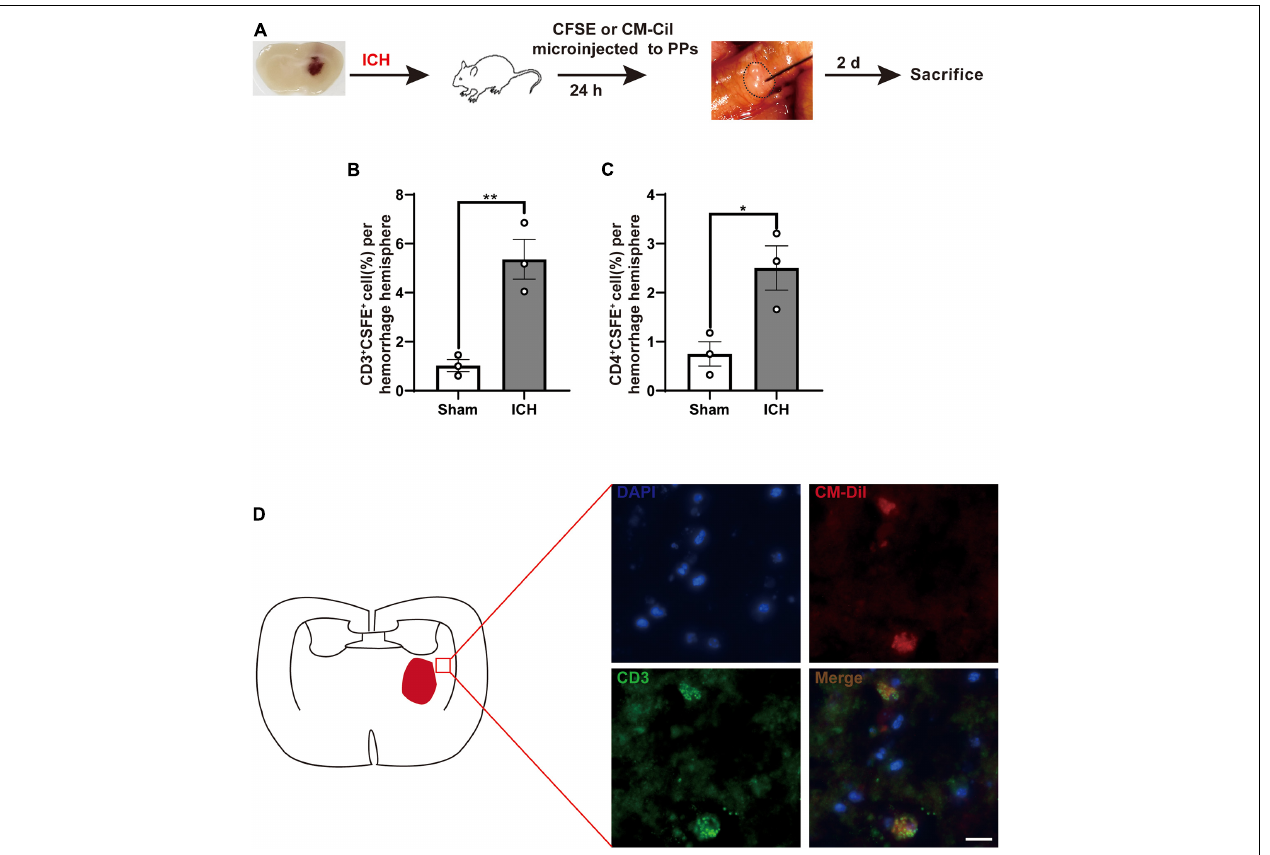
FIGURE 4 | Lymphocytes migrate from the intestine to the brain after ICH. (A) Experiment design for tracking the migration of intestinal PP-derived lymphocytes in mice after ICH. CSFE or CM-Cil was microinjected into PPs 24 h after ICH. Two days later, the brain was dissected and analyzed for dye + T cells. (B,C) Flow cytometry analysis indicated an increased number of CSFE + CD3 + and CSFE + CD4 + in the hemorrhage hemisphere 3 days after ICH compared with sham group ( n = 3). (D) Brain-invading CM-Dil T cells derived from intestinal PPs were identified in the peri-hematoma region and are illustrated as a cumulative map from three mice on one topographical coronal brain section at the bregma level. Data are expressed as the mean ± SEM. * P < 0.05. ** P < 0.01 vs . sham group. Scale bar = 50 µ